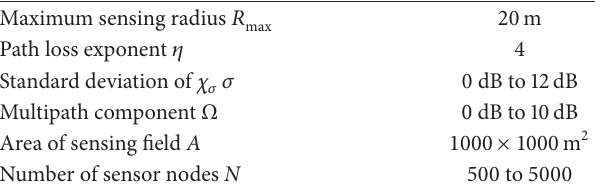
Figure 3: Triangular sensor deployment. Table 1: Simulation parameters and their